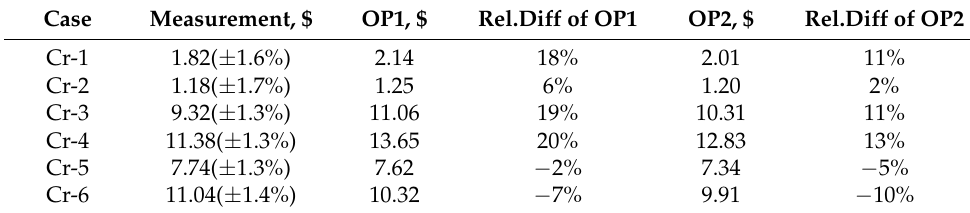
Table 5. Results and comparison of CRW value of